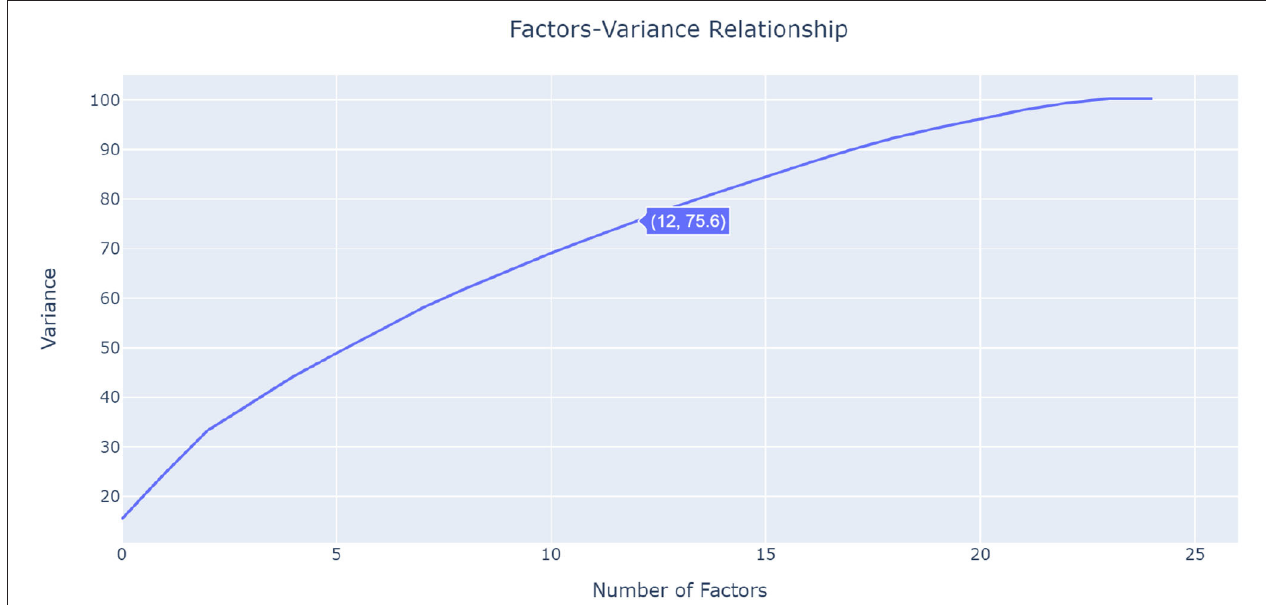
FIGURE 2 | Number of dimensions needed to account for 75% of the total